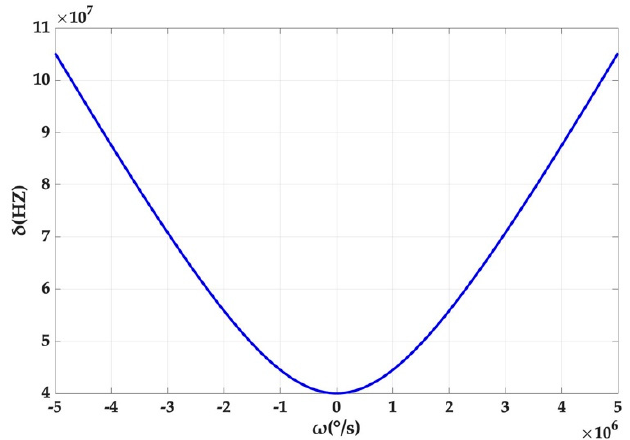
Figure 3. The contrast between the splitting value of the original model and the new model with Kerr noise introduced at different angular rates.